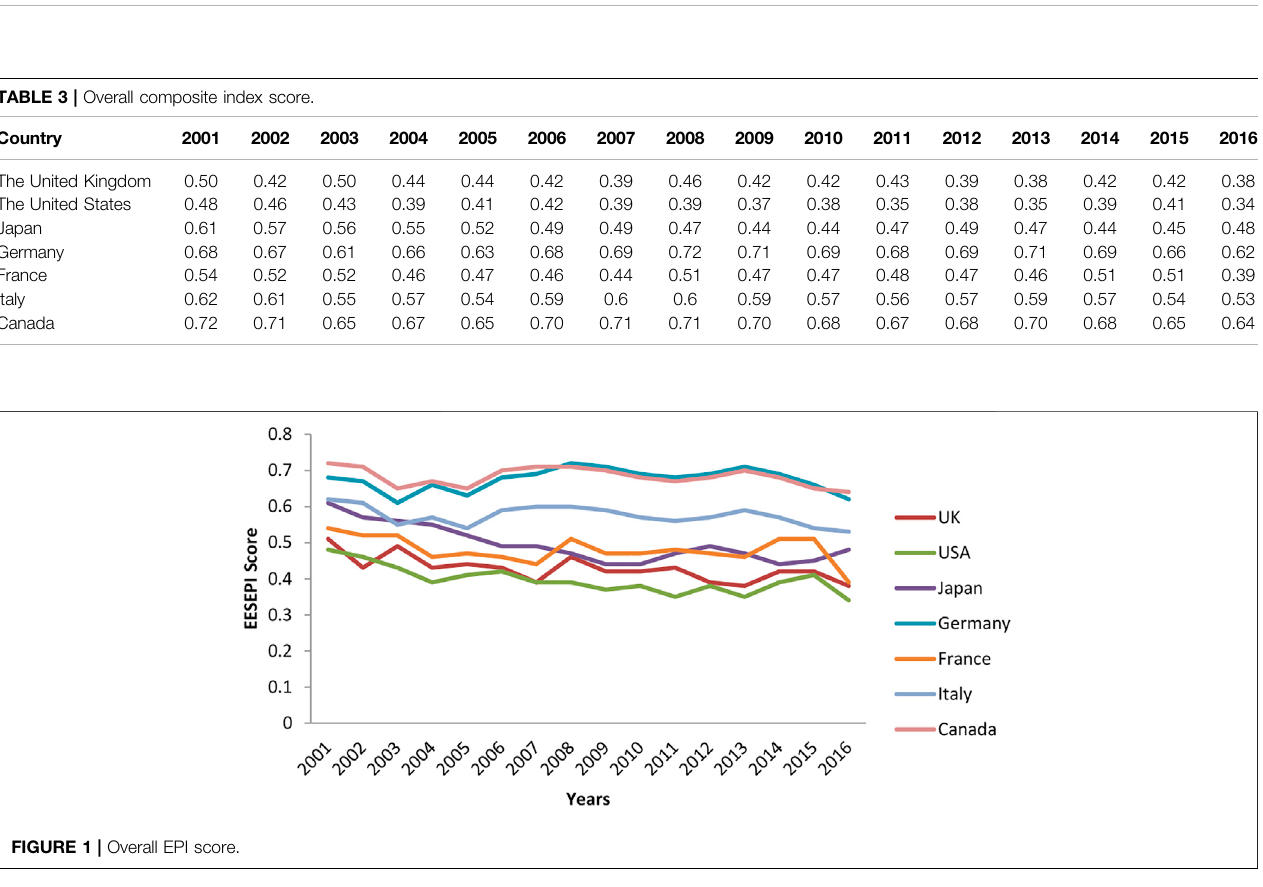
FIGURE 1 | Overall EPI